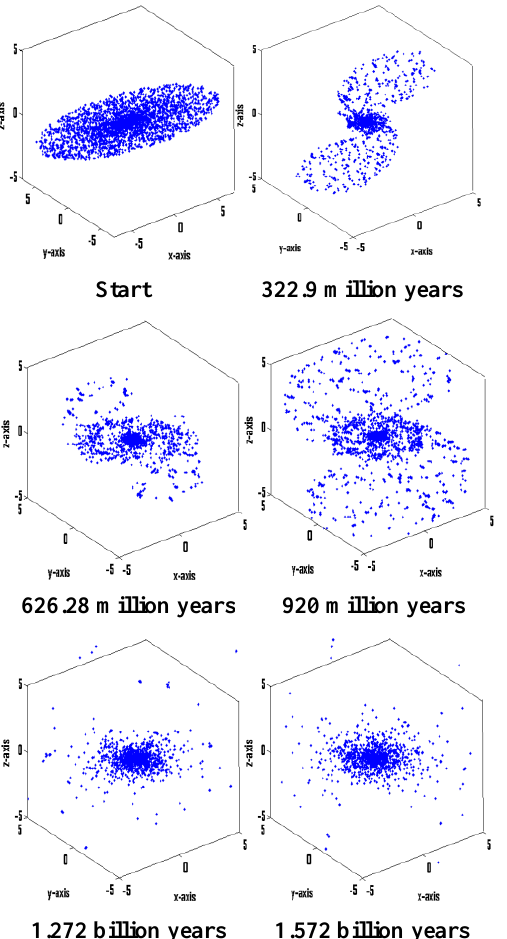
Fig.1: A time sequence of the spiral hot disk model in the xyz plane.